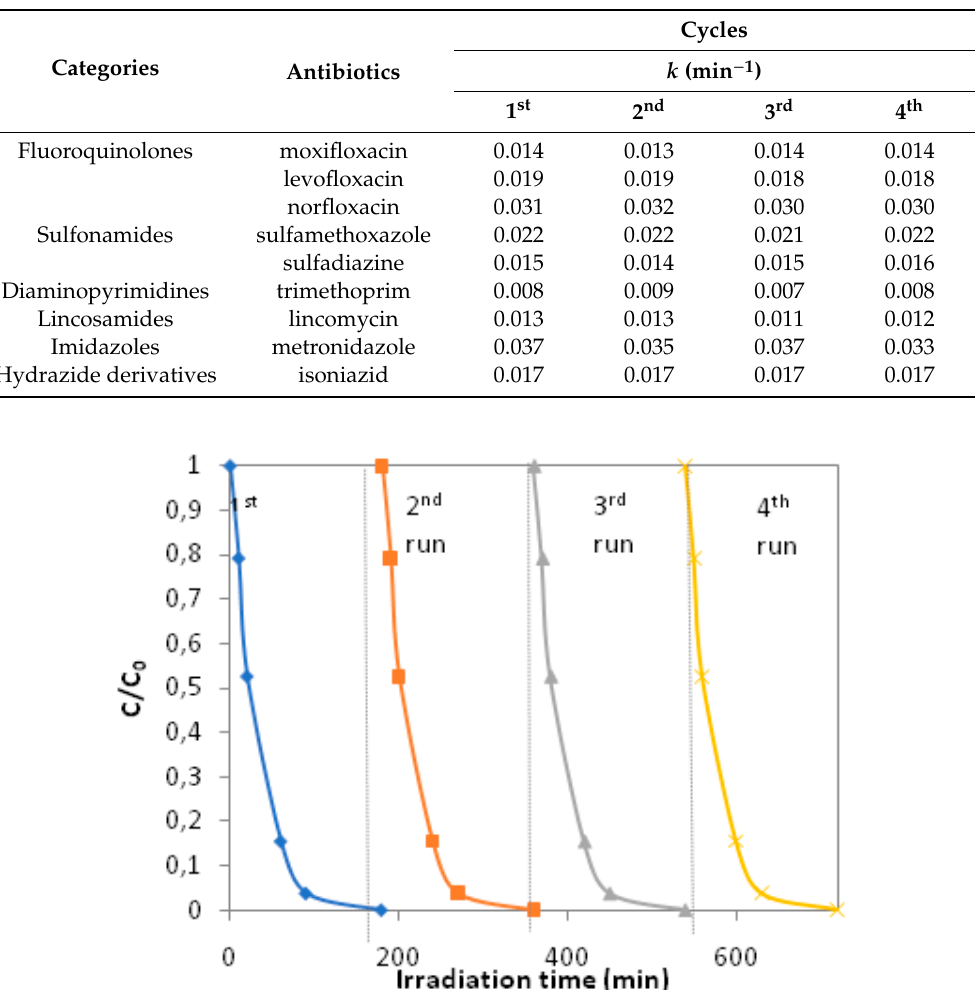
Figure 7. Recyclability test of PLLA–GO–50 wt% TiO 2 film on the photocatalytic degradation of sulfamethoxazole C 0(drug) = 1 mg L − 1 , PLLA–GO– TiO 2 = 1 gL − 1 , I = 750 Wm 2.